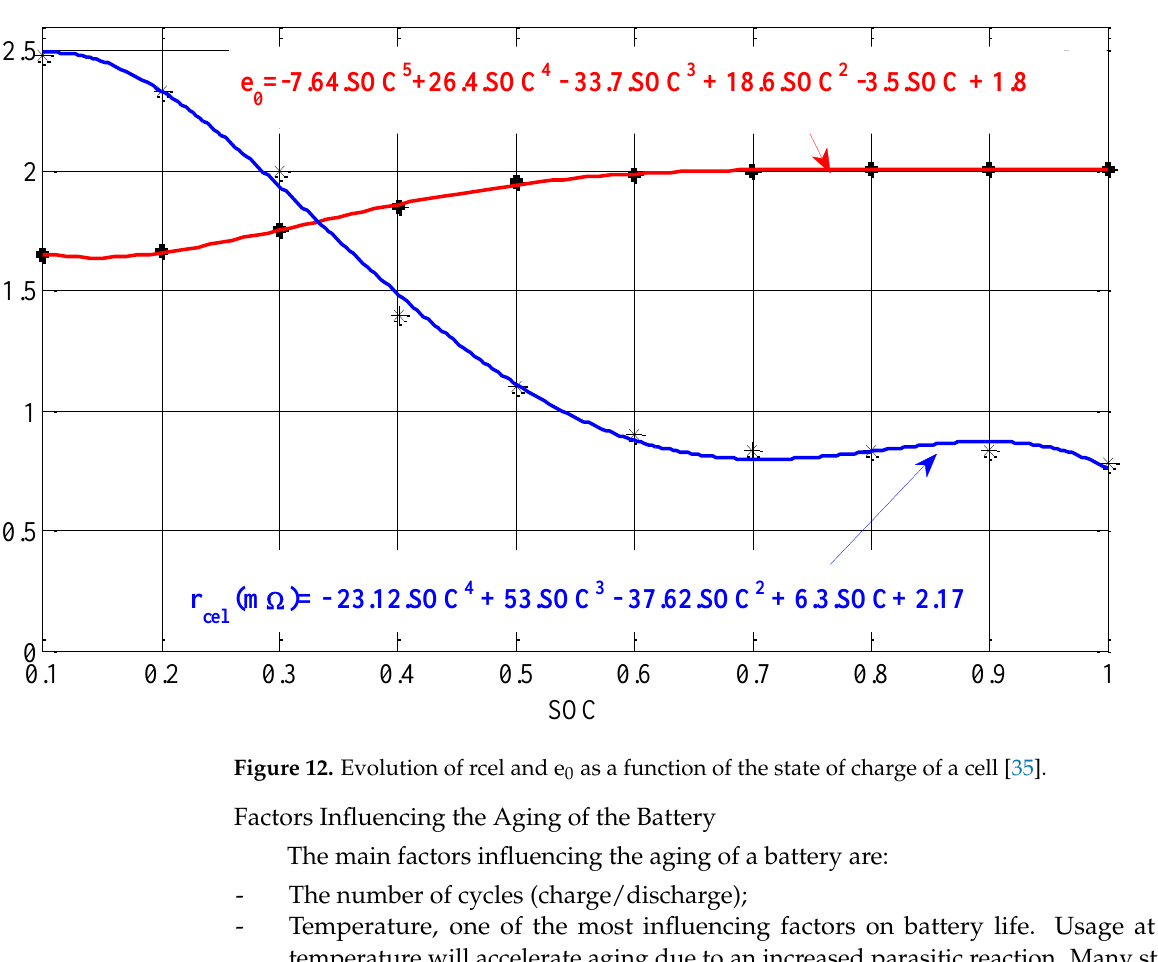
Figure 11. Equivalent electrical diagram of an elementary battery cell.